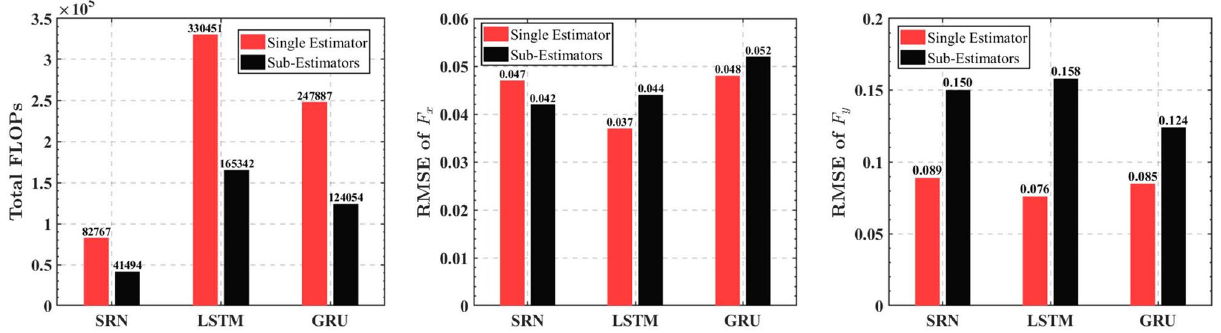
Figure 10. Performance comparisons between the two